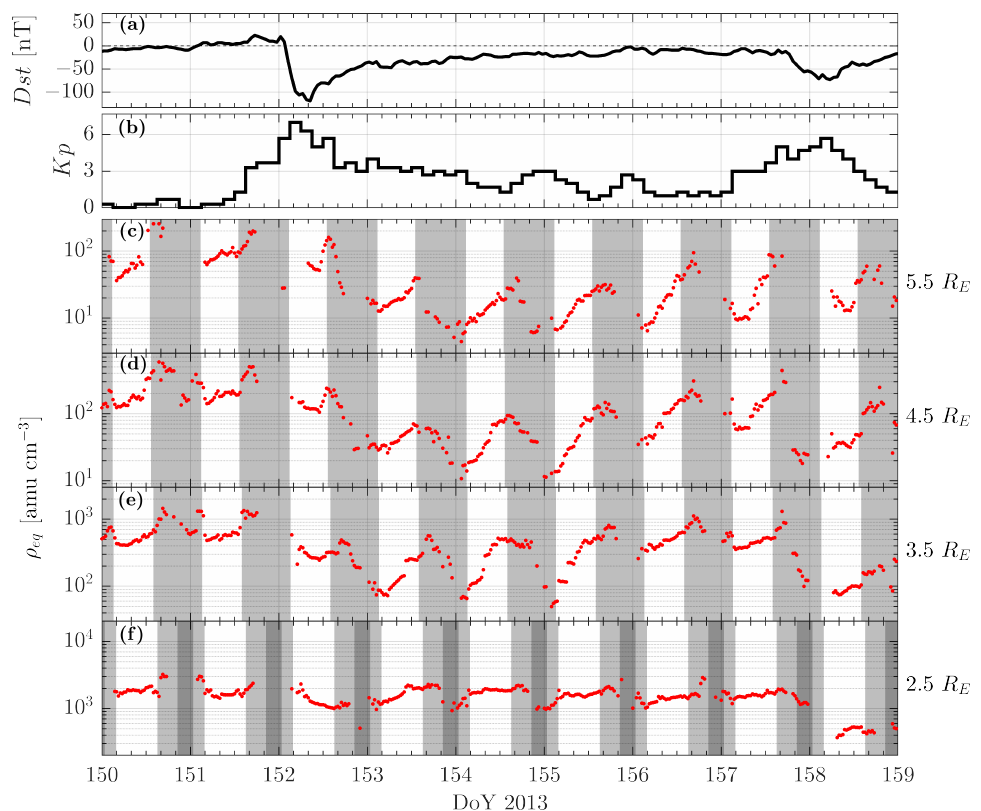
Figure 5. Panels ( a , b ) show variations of the Dst and Kp indices, respectively. Panels ( c – f ) show plasma mass density measurements on 30 May–7 June 2013, evaluated at r eq = 2.5, 3.5, 4.5 and 5.5 R E , respectively, using the fitting procedure described in Section 2. The two top panels show the geomagnetic indices Dst and Kp . Shadowed areas indicate measurements obtained for flux tubes having both (dark shadows) or one (light shadow) footprints not lighted by the